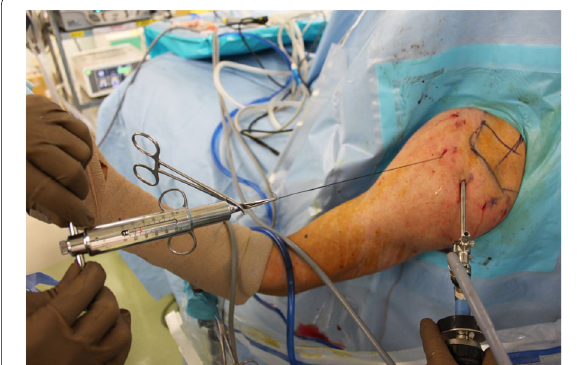
of the torn rotator cuff tendon depending on the tear size and are retrieved from the anterolateral portal. Each nylon is pulled laterally by using a tension